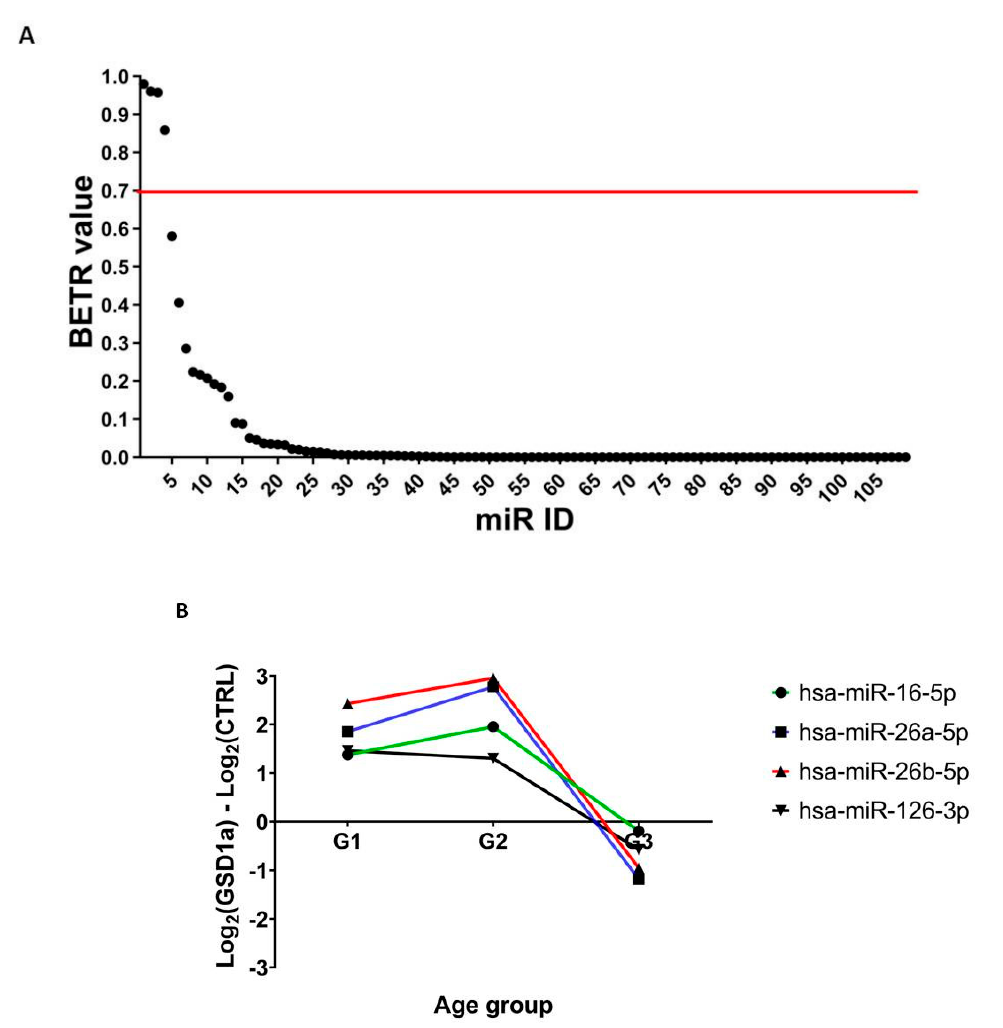
Figure 3. Time-course analysis reveals an age-dependent modulation of Exo-miR expression in GSDIa patients. The plots in (panels A , B ) show the results of the time-course analysis between GSDIa patients and CTRL subjects using the BETR method. Panel ( A ) reports the BETR values of all Exo-miRs sorted in decreasing order. Exo-miRs with a BETR value greater than 0.7 provided the best evidence for differential expression and were considered to be significantly modulated. The red line displays the threshold value to visually differentiate significantly and not significantly modulated Exo-miRs. Panel ( B ) shows the log2 fold change value of the four significantly age-dependent and differentially represented Exo-miRs between GSDIa patients and CTRL subjects according to the BETR method. GSDIa patients and CTRL subjects were grouped into three age groups: G1 (6–10); G2 (11–20); G3 (21–63). The group identifier is shown in the x axis. Different colors and symbols were used in the line plot to differentiate the four modulated Exo-miRs. The legend is reported on the right side of the plot.